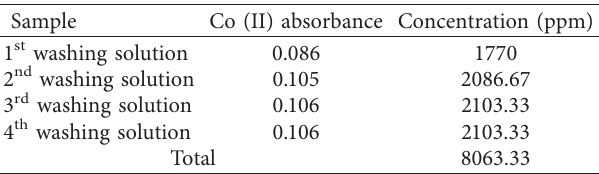
Figure 2: UV spectra of (R)-(+)-citronellal after removed from the MMIP A column using the HPLC pump with the eluent mixture of methanol and acetic acid (9:1, v/v) at a flow rate of 0.05mLmin − 1 . The measurement wavelength was 253nm, and every step of washing was 1h. Table 2: Analysis of the cobalt acetate content after washing se- quence from the MMIP A